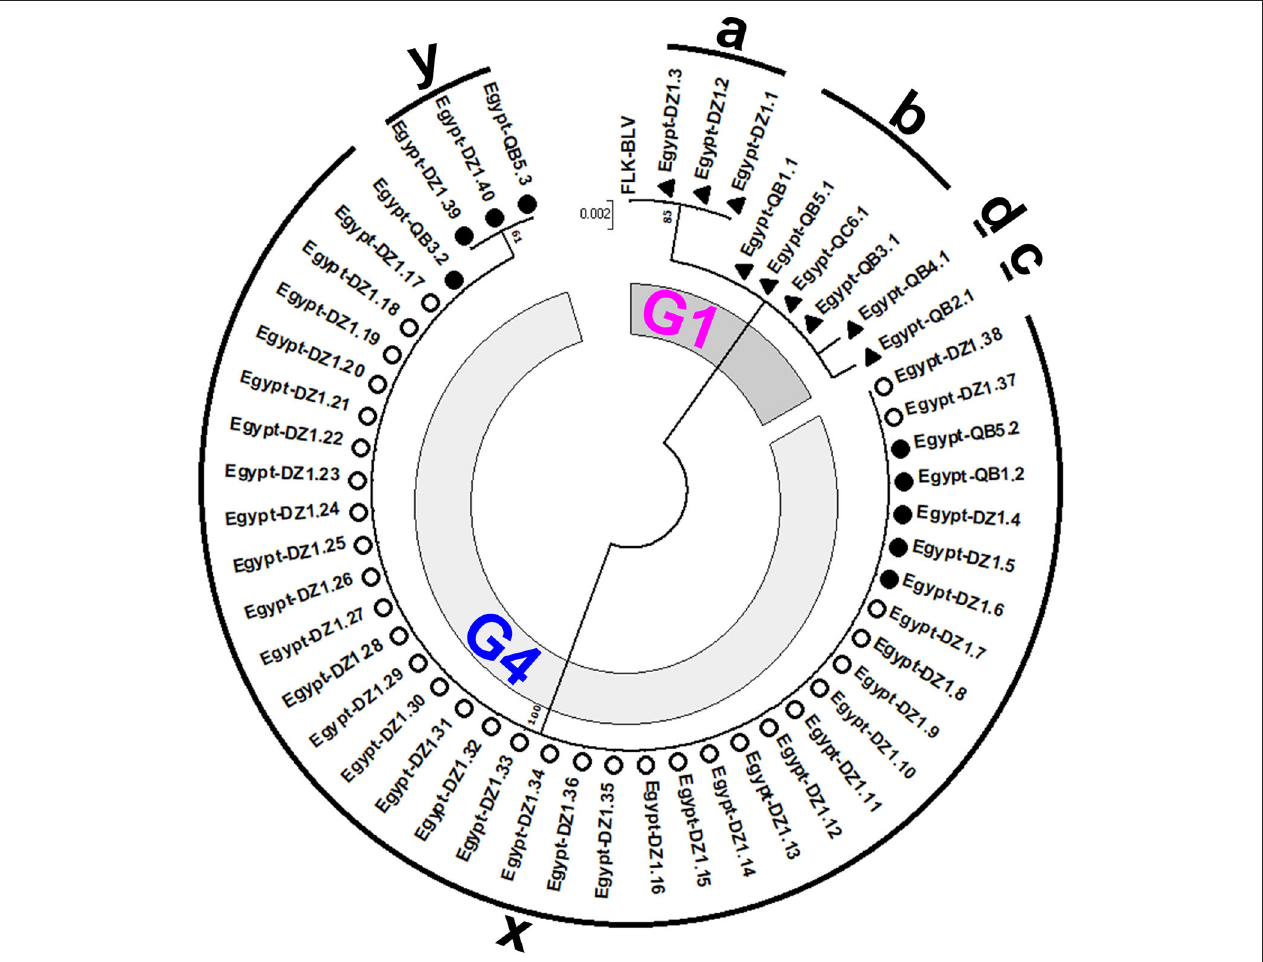
FIGURE 3 | Maximum likelihood (ML) phylogenetic tree based on 501-bp nucleotide of BLV env -gp51 gene from 50 BLV isolates classified into the six genetically distinct strains identified in Egyptian cattle (G1-a, G1-b, G1-c, G1-d, G4-x, and G4-y). This tree was constructed with the sequences of 50 BLV isolates detected in the cattle from different farms at two geographic locations in Egypt, including the 18 typical BLV Egyptian isolates as shown in Figure 2 and other Egyptian isolates detected in different locations, and the reference strain FLK-BLV subclone pBLV913 (accession number EF600696). Egyptian BLV sequences on the tree are indicated by farm ID, and sample number. BLV isolates that belong to genotype-1 are indicated using filled triangles ( N ), while those that belong to genotype-4 are indicated using open ( ◦ ) and filled (•) circles. Sequences for each distinct BLV strain are indicated via alphabets around the circumference of the figure. The 18 typical Egyptian BLV isolates from identical samples were aligned as shown in Figure 4 and are indicated by filled circles (•) and triangles ( N ). Other isolates are indicated using open circles ( ◦ ). The genotypes are shown as G1 and G4. The bar at the above portion denotes